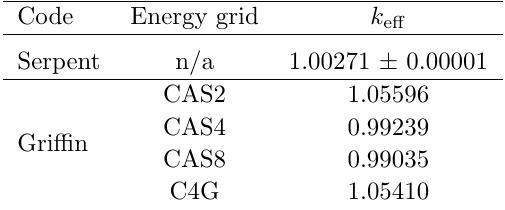
Table 11. Eigenvalues calculated by cases without SPH